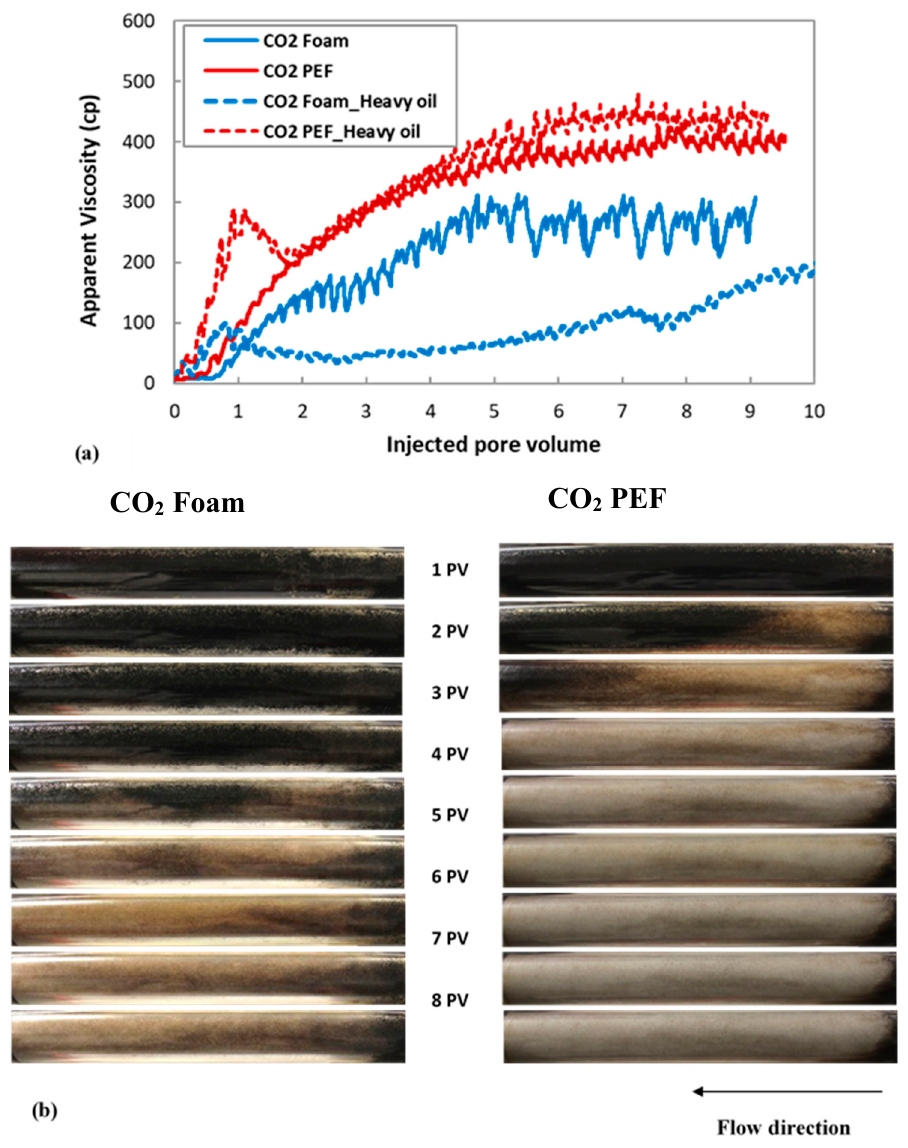
Figure 9. Higher apparent viscosity and better sweep efficiency of PEF than that of foam. ( a ) CO 2 foam/PEF apparent viscosity profiles in water-saturated and oil-saturated sandpack, and ( b ) images of sandpack during CO 2 foam/PEF injection showing sweep efficiency. The black color shows the oil-saturated area and the white zone shows the swept area by foam/PEF.